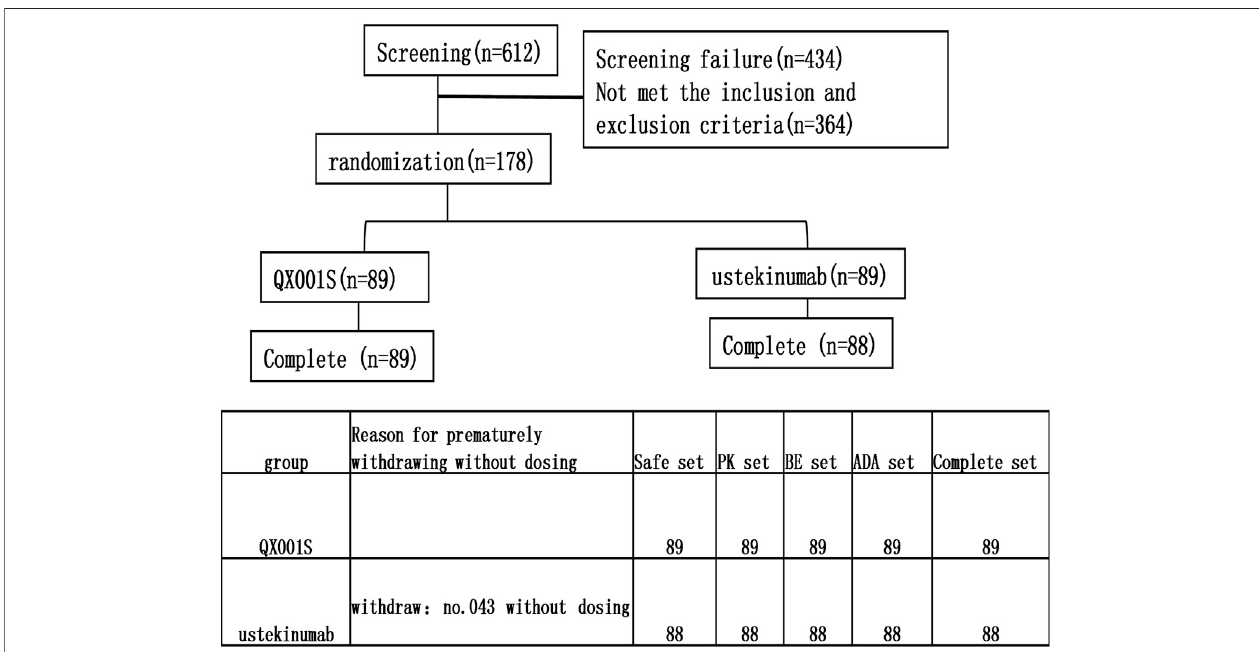
FIGURE 1 | The fl ow chart for the study and reasons for premature withdrawal before